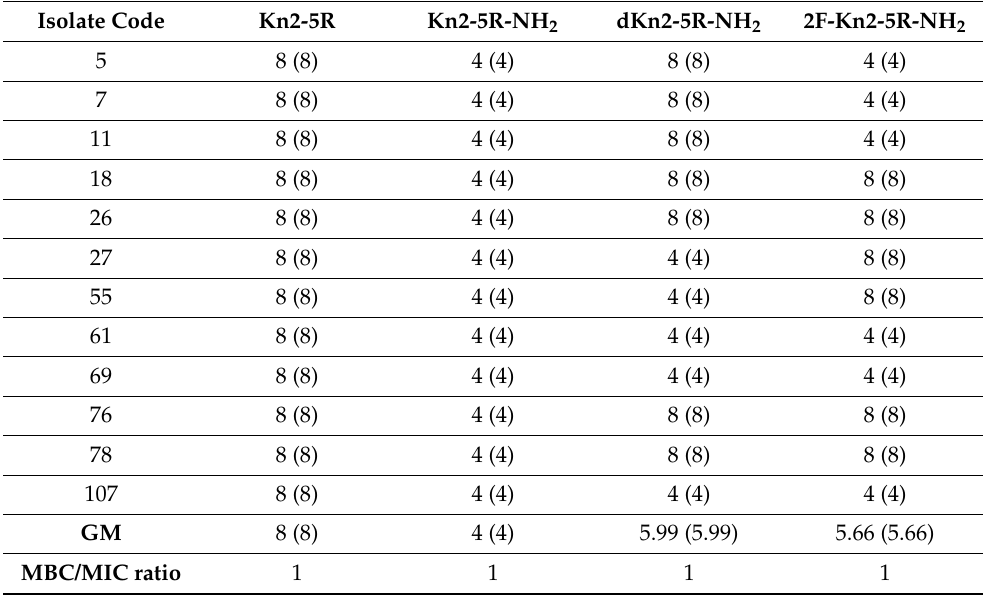
Table 3. Antibacterial activity of the variant peptides shown as MIC (MBC) in µ M tested against 12 clinical Salmonella